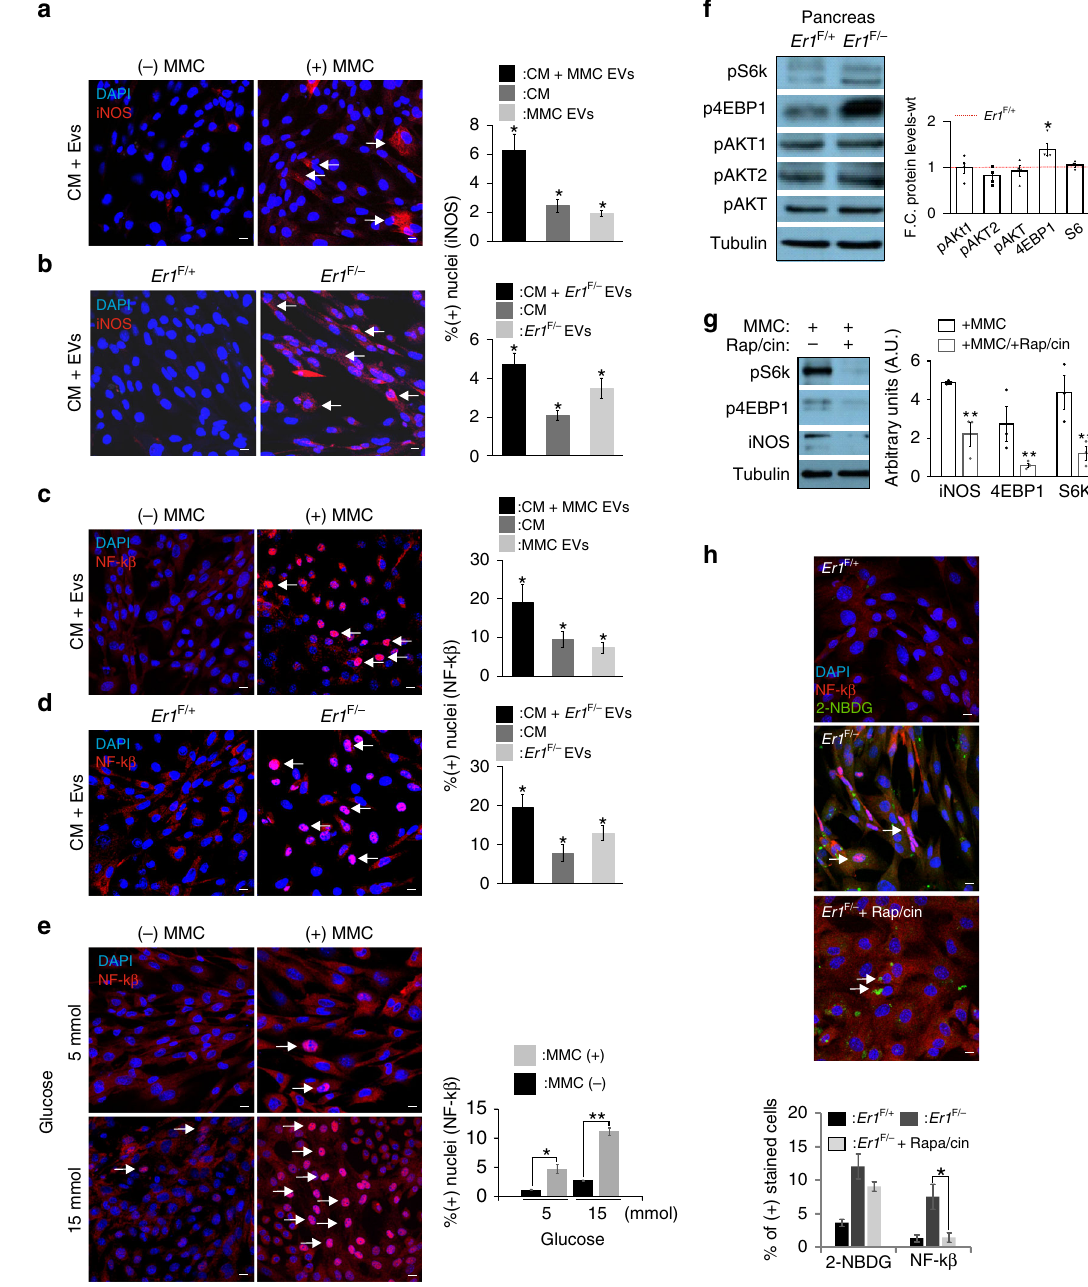
Fig. 7 Glucose uptake activates mTOR and pro-in fl ammatory responses in EV-recipient cells. a Immuno fl uorescence detection of iNOS accumulation (indicated by the arrowhead) in PPCs exposed to culture media (CM) and the EVs derived from MMC-treated and untreated control macrophages ( n = 3, >600 cells per treatment) or b Er1 F/ − and Er1 F/ + macrophages ( n = 3, > 1200 cells/treatment) (see also Supplementary Fig. 8D). c Immuno fl uorescence detection of NF-k β nuclear translocation (indicated by the arrowhead) in PPCs exposed to CM and the EVs derived from MMC-treated and untreated control macrophages or ( n = 3, >700 cells per treatment). d Er1 F/ − and Er1 F/ + macrophages (see also Supplementary Fig. 8E). ( n = 3, >500 cells per treatment). e Immuno fl uorescence detection of NF-k β (shown by the arrowhead) in PPCs exposed to CM supplemented with EVs from MMC-treated and control macrophages upon low (5 mmol) or high (15 mmol) glucose concentration ( n = 4, >750 cells per treatment; see also Supplementary Fig. 9A – C). f Western blotting of phosphorylated pS6K, phosphorylated p4EBP1, phosphorylated pAKT1, phosphorylated pAKT2 and phosphorylated pAKT protein levels in Er1 F/ − and Er1 F/ + pancreata ( n = 4). The graph represents the fold change (F.C) of indicated protein levels in Er1 F/ − pancreata to wt. controls. g Western blotting of pS6K, p4EBP1 and iNOS protein levels in MMC-treated macrophages exposed to rapamycin ( n = 3, Rap/cin; as indicated). The graph represents the fold change of protein levels in MMC-treated macrophages exposed to rapamycin compared to MMC-treated macrophage control (ctrl.) cells. h Immuno fl uorescence detection of NF-k β and 2-NBDG in PPCs (indicated by the arrowheads) exposed to CM supplemented with EVs derived from Er1 F/ − and Er1 F/ + BMDMs in the presence or absence of rapamycin (Rap/cin). ( n = 6, > 1000 cells counted per treatment). The graph shows the percenatge of positively stained cells. Error bars indicate S.E.M. among replicates ( n ≥ 3). Asterisk indicates the signi fi cance set at p -value: * ≤ 0.05, ** ≤ 0.01 (two-tailed Student ’ s t -test). Gray line is set at 5 μ m